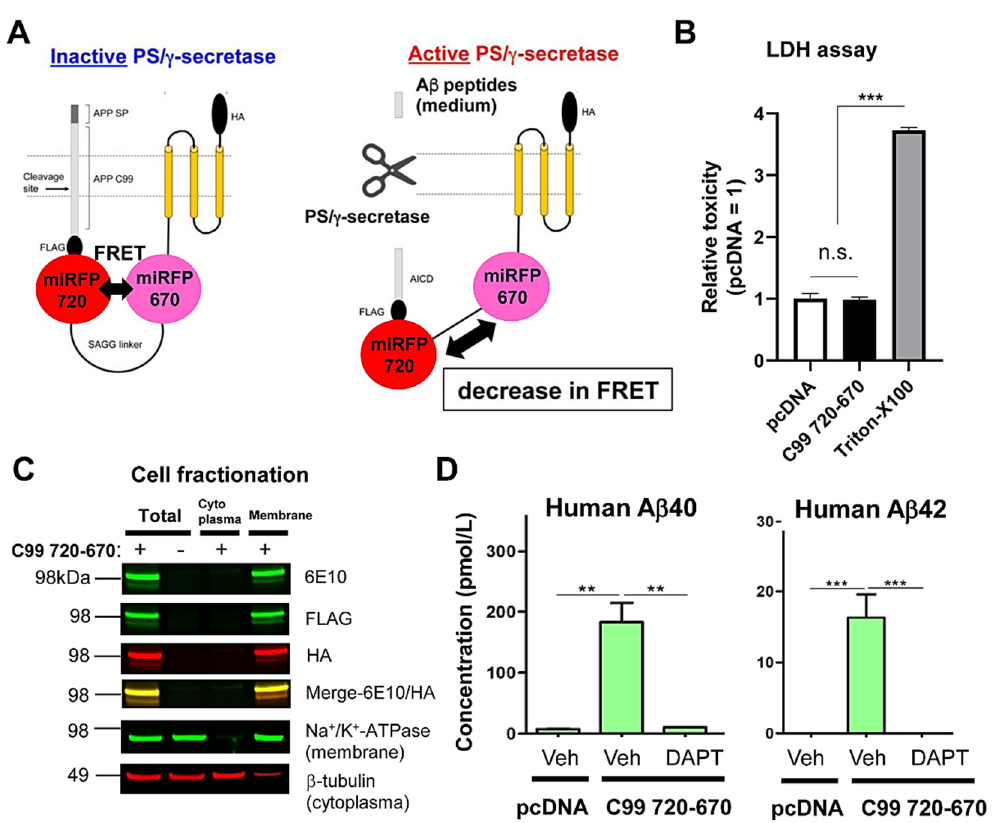
Figure 1. The C99 720-670 biosensor is cleaved by PS / γ -secretase. ( A ) A schematic diagram of the C99 720-670 biosensor. Endogenous PS / γ -secretase cleaves the APP C99 in the C99 720-670 biosensor, which results in a decrease in FRET between miRFP670 (donor) and miRFP720 (acceptor). ( B ) The LDH cytotoxicity assay revealed that the C99 720-670 biosensor causes no toxicity in CHO cells. The 1% Triton-100X treatment was used as a positive control of toxicity. n = 4 biological replicates; mean ± SD; n.s., not significant; *** p < 0.001, one-way factorial ANOVA. ( C ) The cell fractionation assay evidenced the integration of C99 720-670 biosensor in membrane. The 6E10 antibody recognizes the N-terminus, and the FLAG and HA antibodies capture the middle and the C-terminus of C99 720-670 biosensor, respectively. Na + / K + -ATPase and β -tubulin were used as membrane and cytoplasmic markers, respectively. ( D ) Detection of human A β 40 ( left ) and A β 42 ( right ) in the conditioned medium of C99 720-670 expressing CHO cells by ELISA, which was inhibited by the treatment with 1 µ M DAPT (PS / γ -secretase inhibitor). n = 3 biological replicates; mean ± SD; ** p < 0.01, *** p < 0.001, one-way factorial ANOVA.